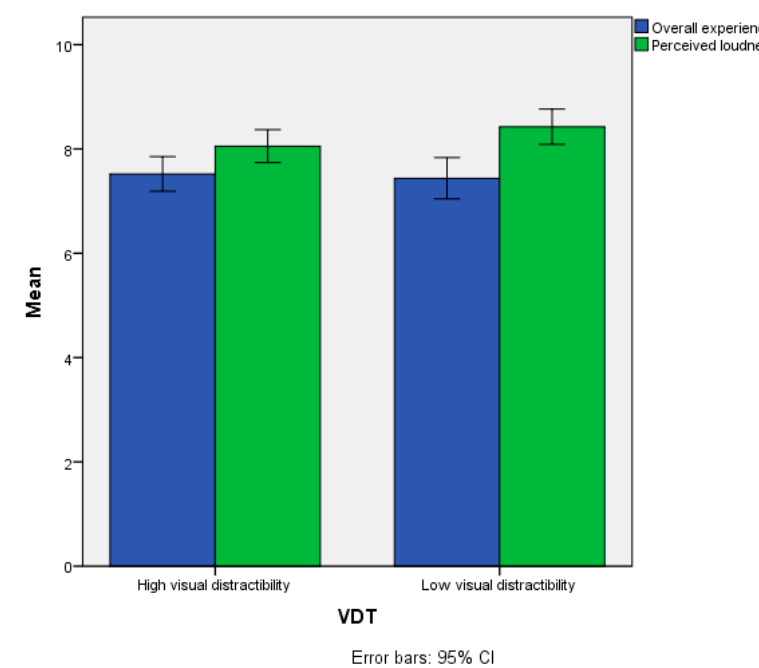
Figure 8. Mean scores of the Perceived loudness and Overall experience items as a function of the VDT variable.